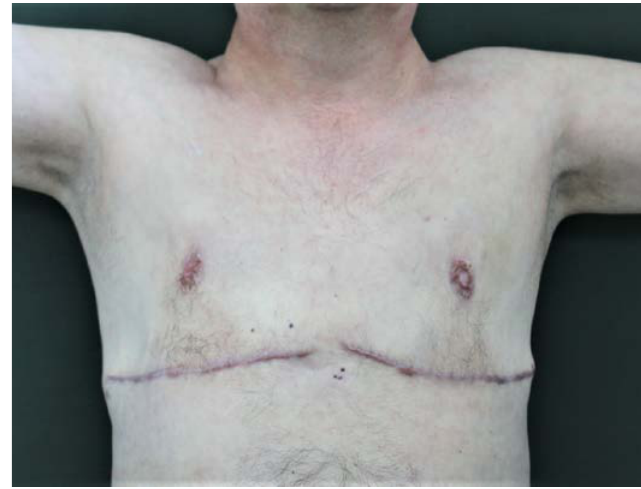
Figure 5. The sixth-month postoperative clinical follow-up.